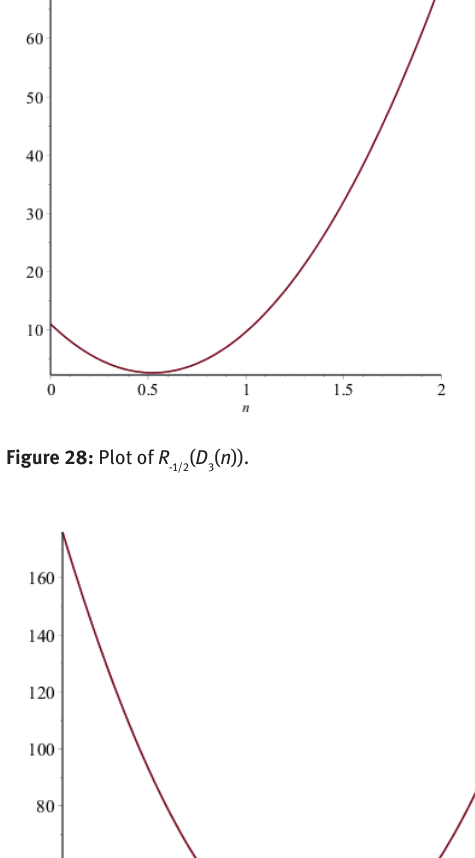
Figure 26: Plot of M